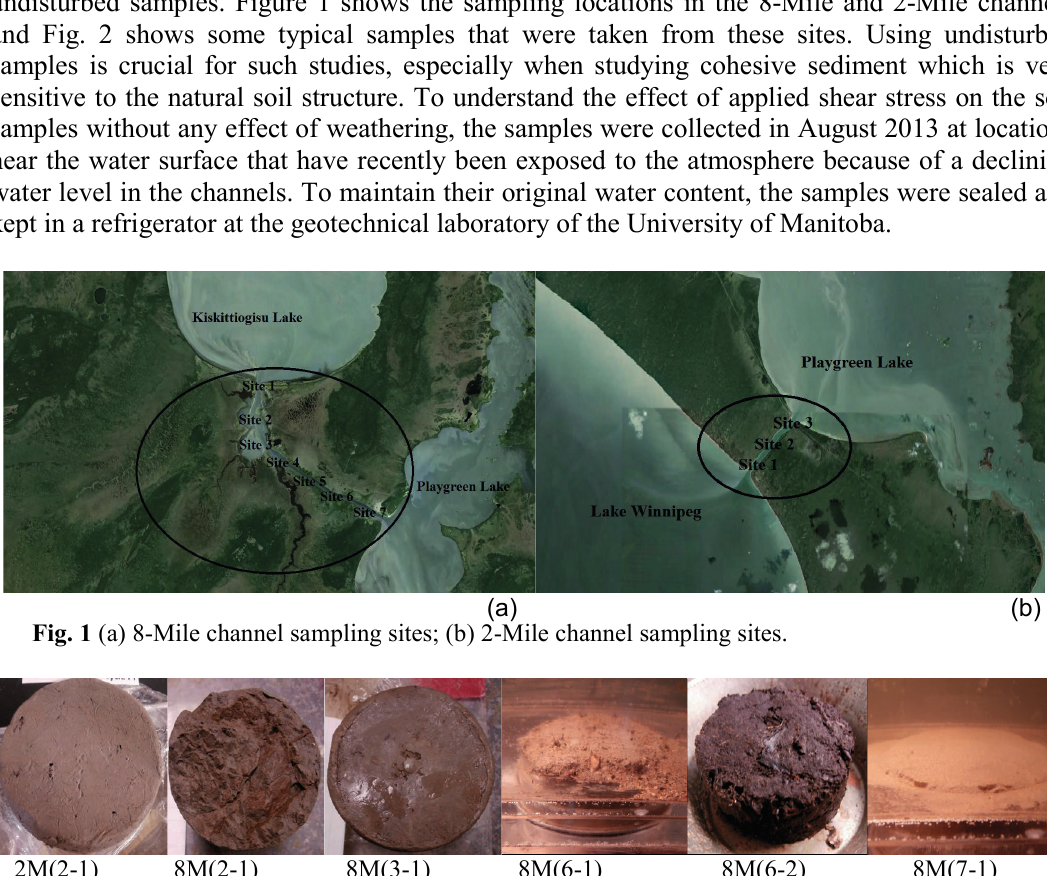
Fig. 2 Soil samples from 2-Mile channel (2M) and 8-Mile channel